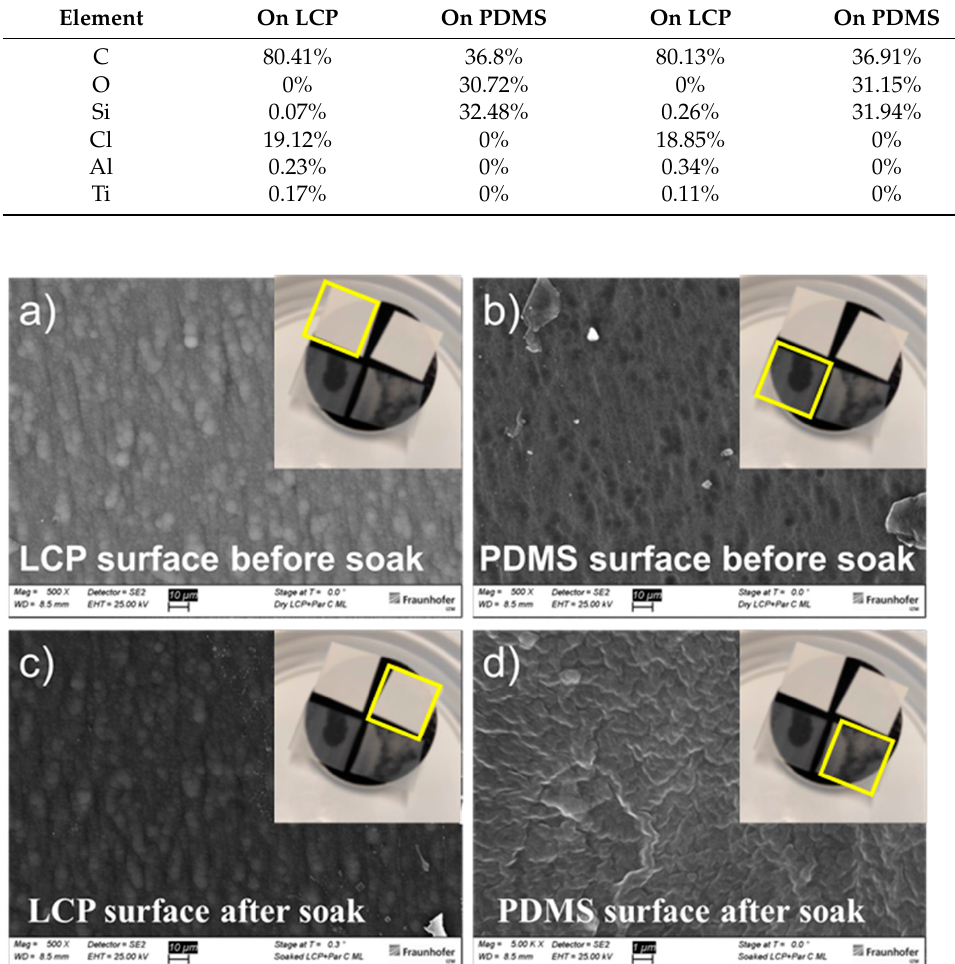
Figure 4. SEM images of LCP ( a , c ) and PDMS ( b , d ) surfaces after T-peel test before and after soak-